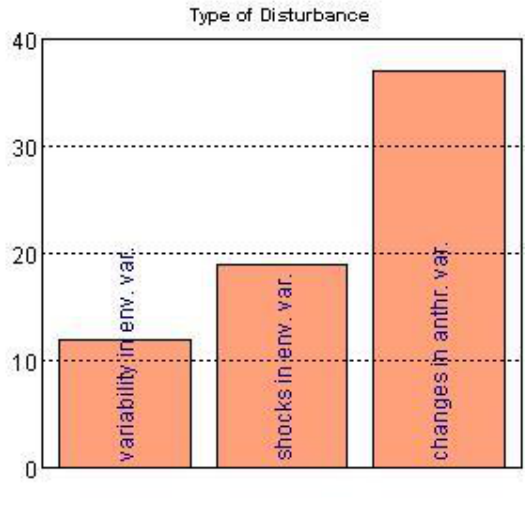
Figure A3: Types of disturbances represented in the models (Scale: number of papers out of all papers included in review